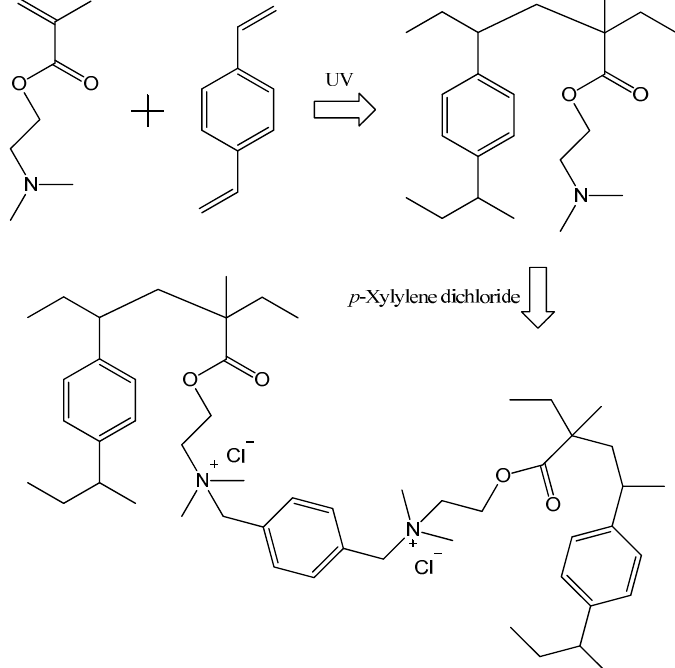
Figure 1. Reaction scheme of the anion-exchangeable polymer, with quaternary ammonium groups and two different kinds of cross-linking sites. and two di ff erent kinds of cross-linking